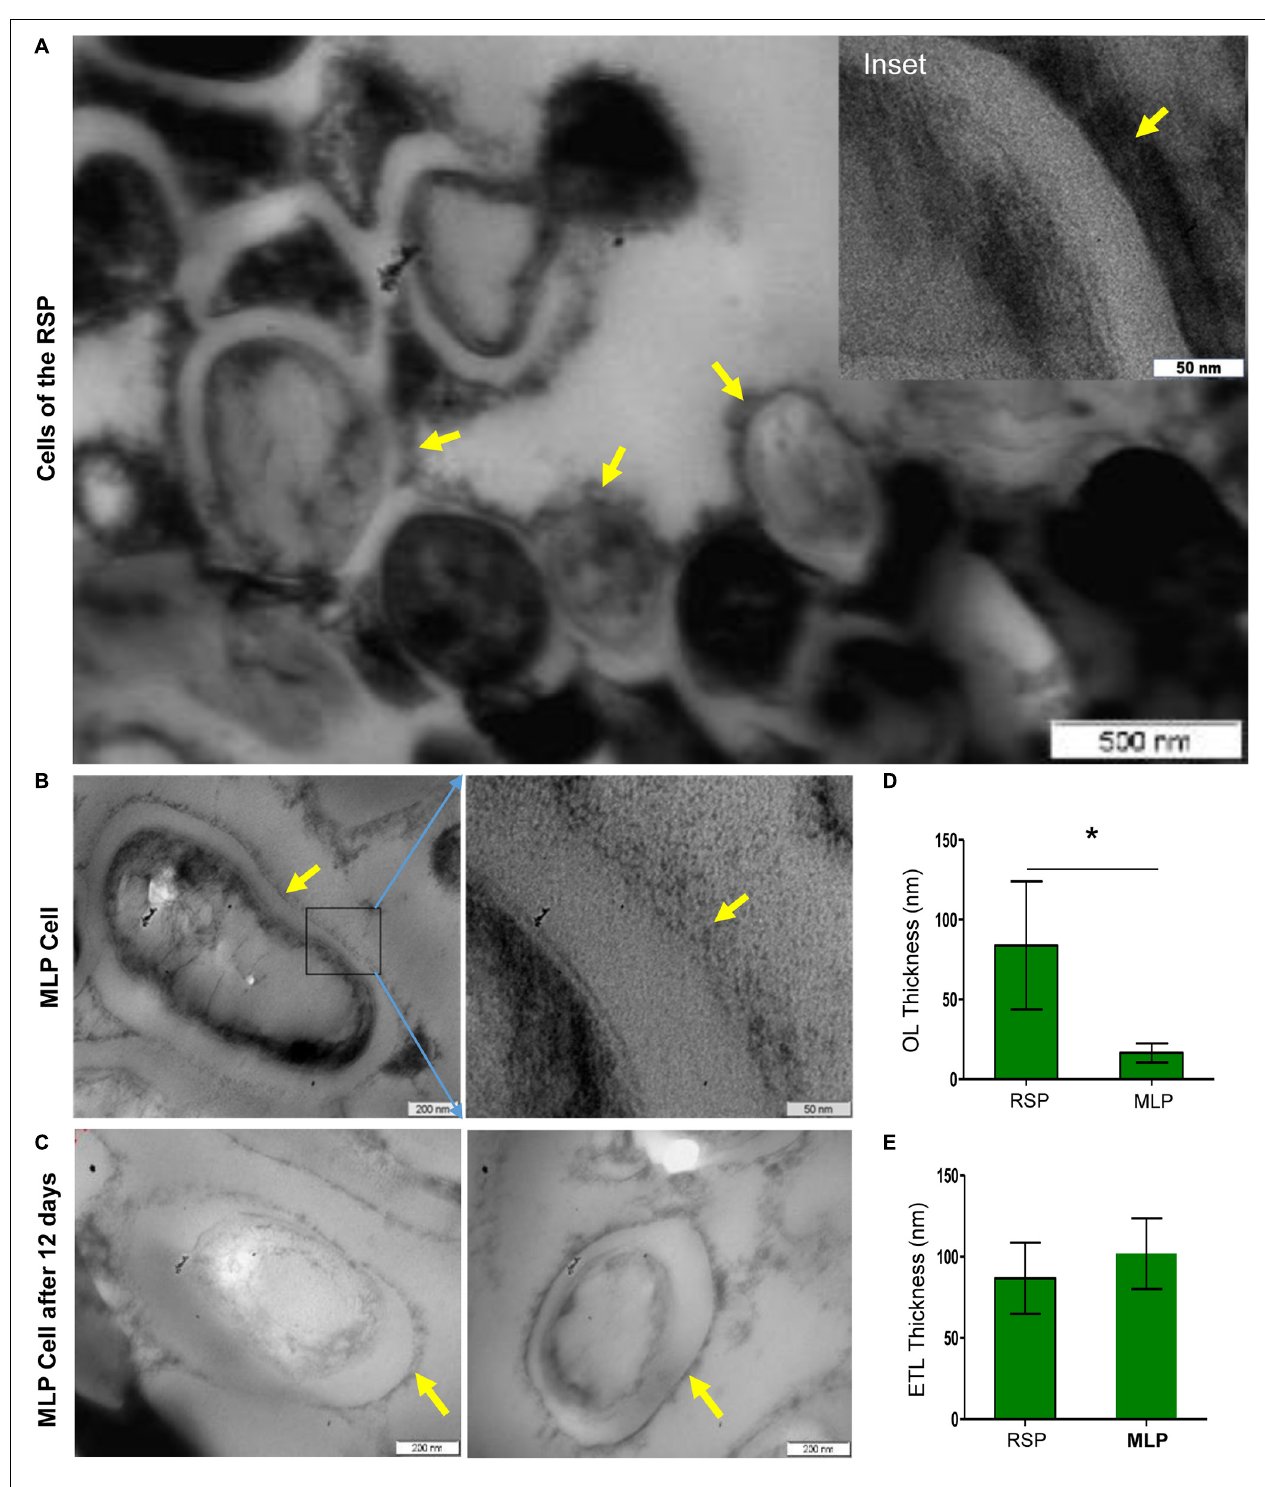
FIGURE 4 | Presence of TCOL in the M. tuberculosis cells from the rifampicin surviving population (RSP). (A,B) Transmission electron micrograph of the cells of the rifampicin surviving population (RSP; 12th day of exposure) and of the MLP population. (A) The cells of the RSP with thickened capsular outer layer (TCOL). (B) The MLP cell (control) with NCOL. Magnified images are shown as inset in (A) and on the respective adjacent panels in (B) . The NCOL of the MLP cells cultured for 12 days without rifampicin is shown in (C) . The yellow arrows indicate TCOL/NCOL of RSP/MLP, respectively. (D) Thickness (in nm) of the TCOL/NCOL of the cells of the RSP and MLP population. ∗ indicates p value < 0 . 05. (E) Thickness (in nm) of electron transparent layer (ETL) of the cells of the RSP and MLP populations.